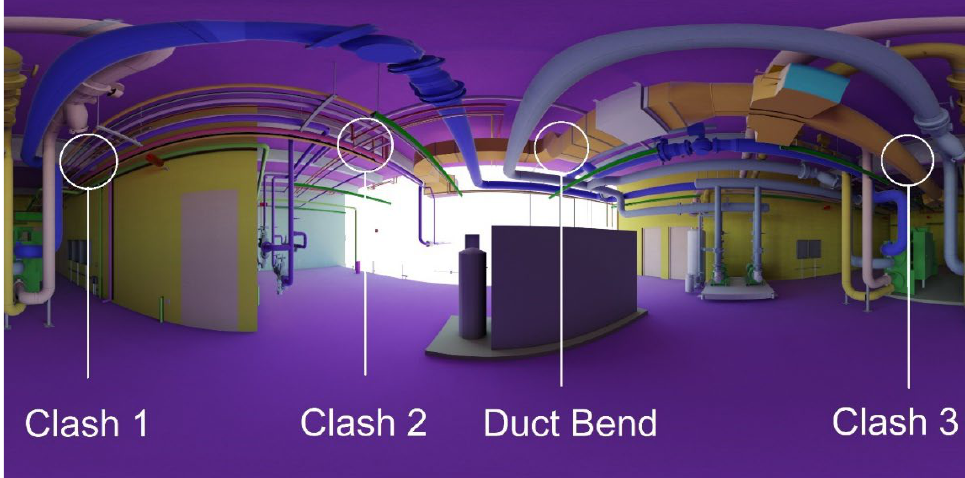
Figure 1. Clash groups in Experiment A.